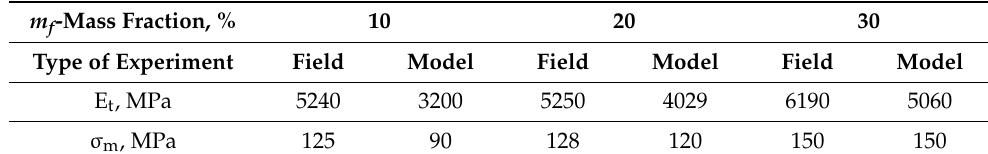
Table 4. Comparison of numerical and field experiment results.